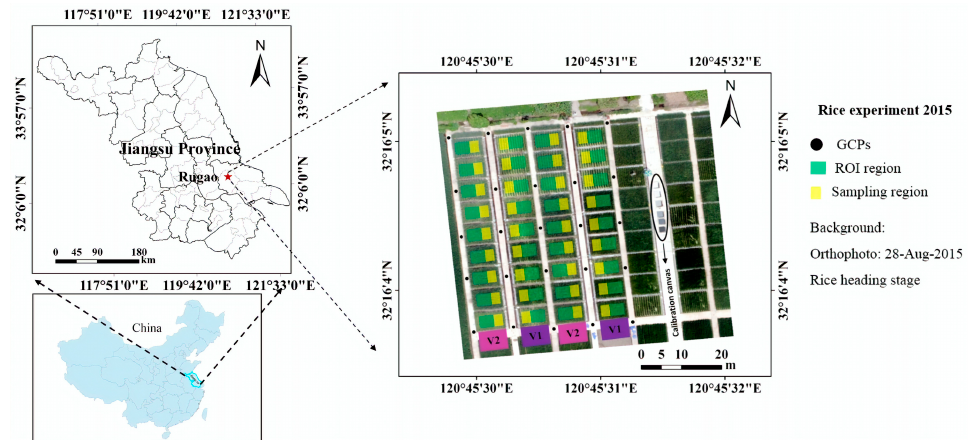
Figure 1. Study site: rice experiment at the NETCIA experimental station in 2015. GCPs, ground control points used for band to band registration.